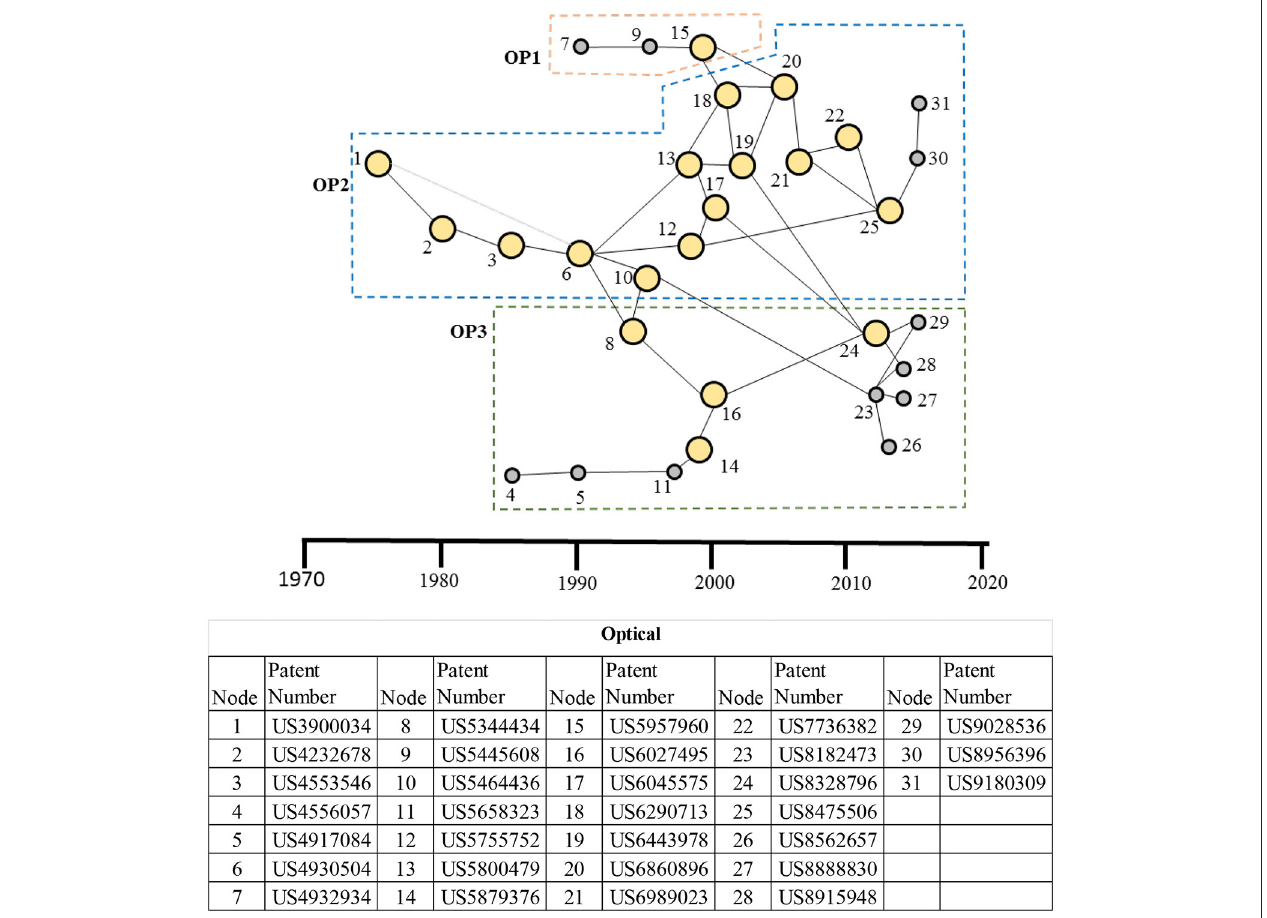
FIGURE 9 | Main paths for the optical therapeutic domain. OP1: A patent cluster for photochemical stimulation of tissue; OP2: a patent cluster for stimulation of nerves of using light; and OP3: a patent cluster for skin treatment using a laser. The table presents details of each patent in the main paths. High-persistence patents are shown as bigger yellow circles, whereas the low-persistence patents are shown as smaller gray